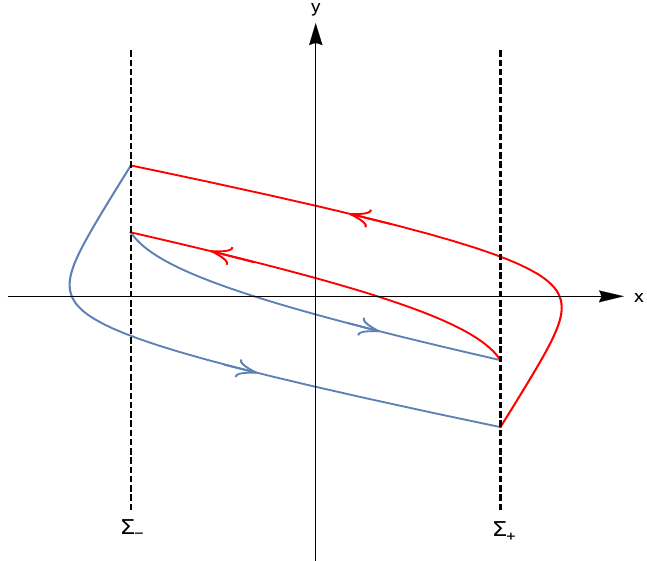
Fig. 7 The two symmetric periodic orbits existing for ( x E , y E ) = ( − 2 , − 1 ) and γ = 0 . 8. One of them takes the three zones and is unstable. The other one takes only the central zone and is stable. The blue lines (resp. red lines) correspond to valid solutions for the S U − system (resp. S L −